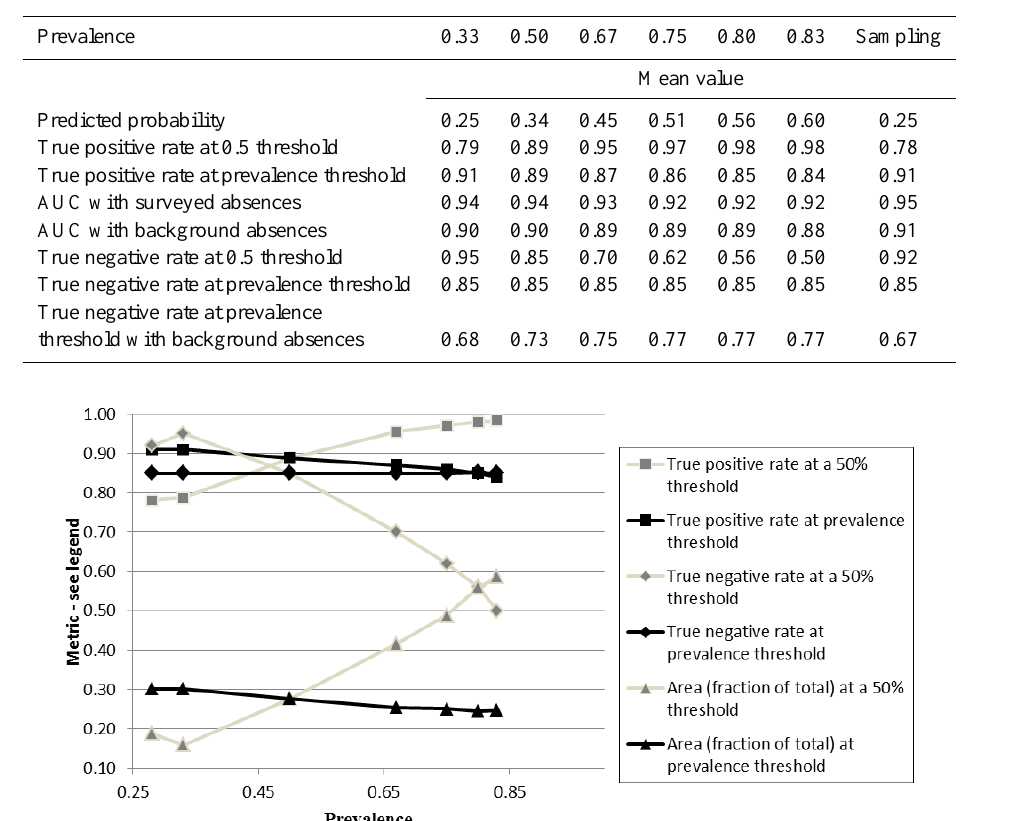
Table 2. Mean values for predicted probability, true positive rate, AUC, and true negative rate for varying modeling prevalences and sampling prevalence (mean sampling prevalence = 0.28, range = 0.09–0.69).